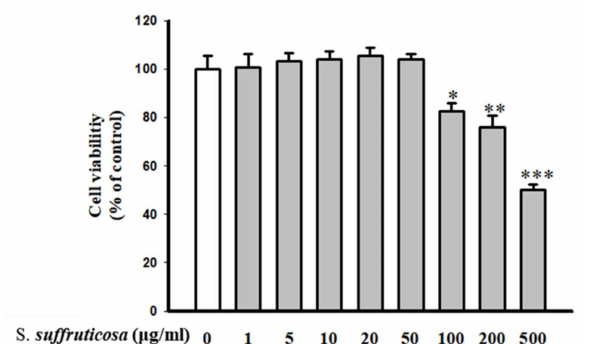
Figure 3. E ff ect of Securinega su ff ruticosa on cell viability of human umbilical vein endothelial cells (HUVECs). Cells were treated with leaf extract of Securinega su ff ruticosa (0–500 µ g / mL) for 24 h. The data are expressed as a percentage of basal value and are the means ± S.E. of five independent experiments with four dishes. * p < 0.05, ** p < 0.01, *** p < 0.001 versus